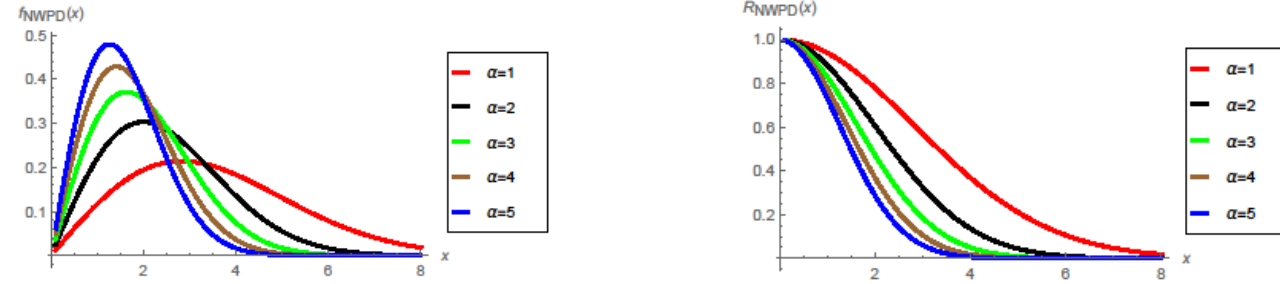
Figure 2. The hazard and distribution functions of the NWPD with 2, 4  =